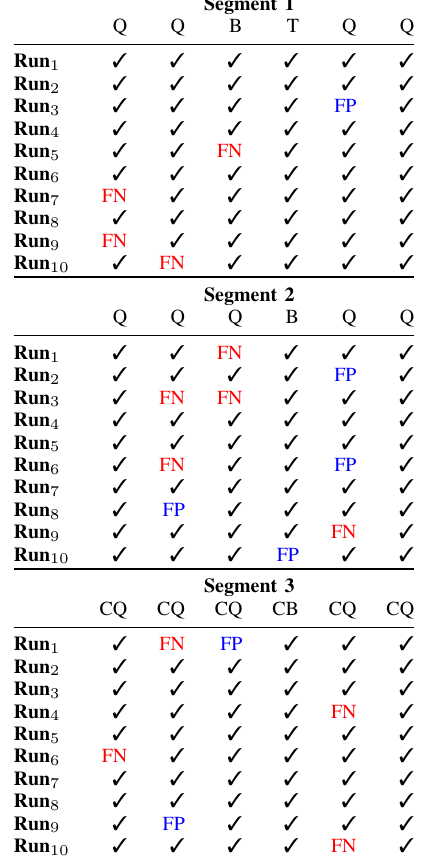
TABLE I S UCCESSFULLY RECOGNIZED GESTURES , FALSE POSITIVES (FP) AND FALSE NEGATIVES (FN) FOR THE RIGHT HAND